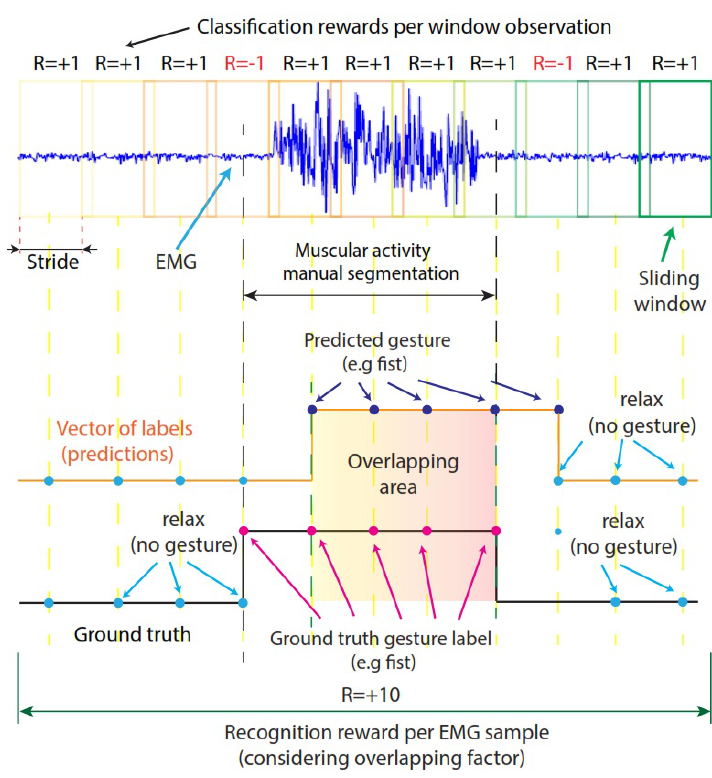
Figure 5. Rewards that the agent obtains when it interacts with the